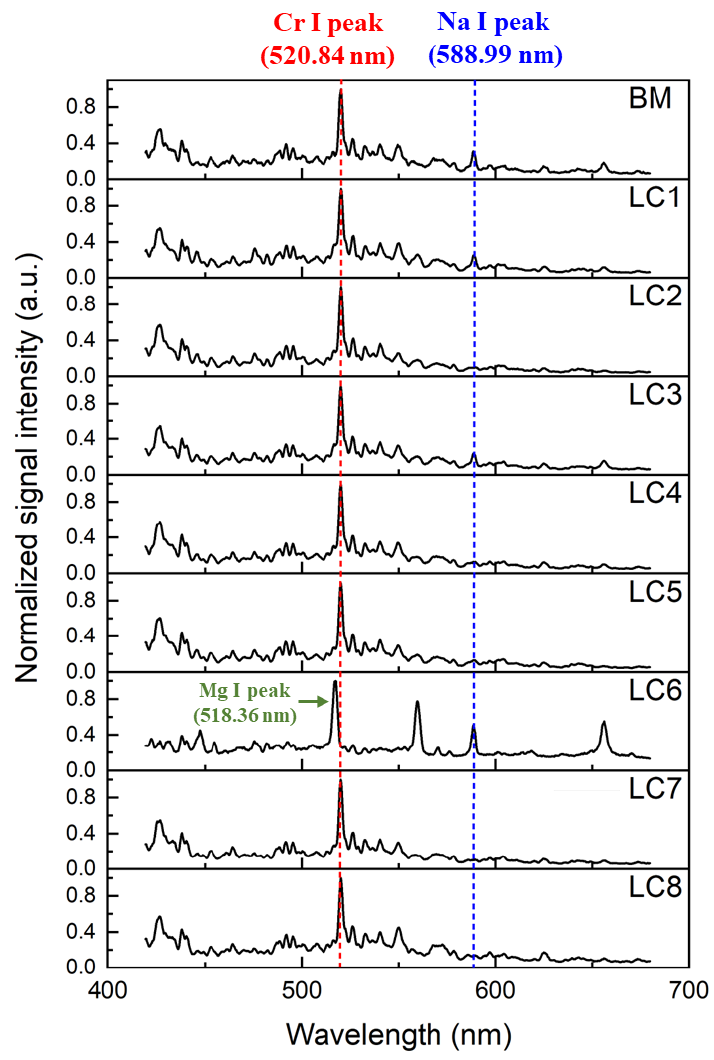
Figure 4. Normalized LIBS spectra of the base metal and laser-cleaned specimens.